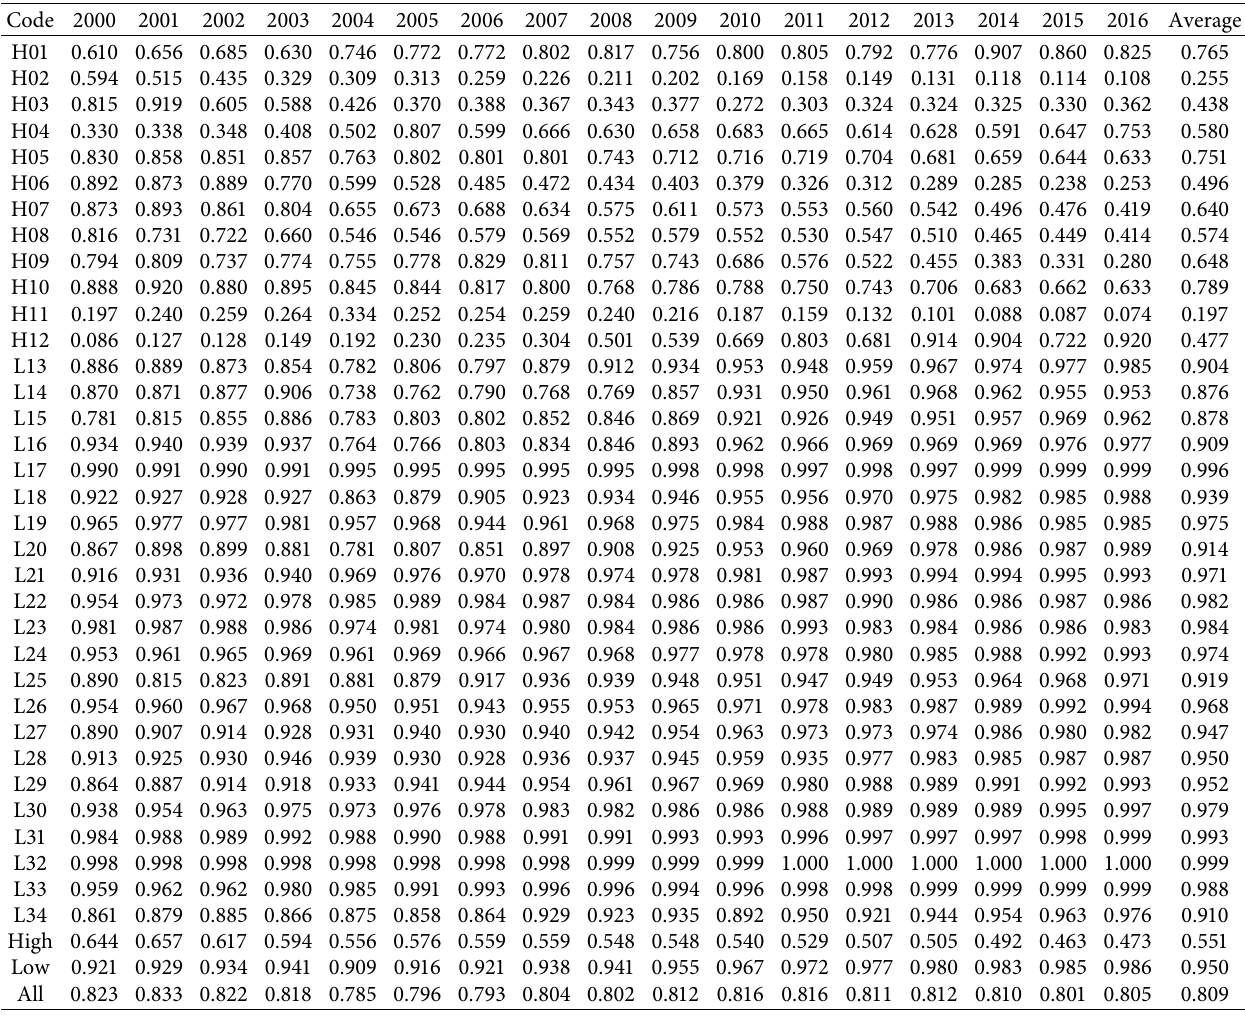
Table 7: Metafrontier green efficiency of China’s industrial